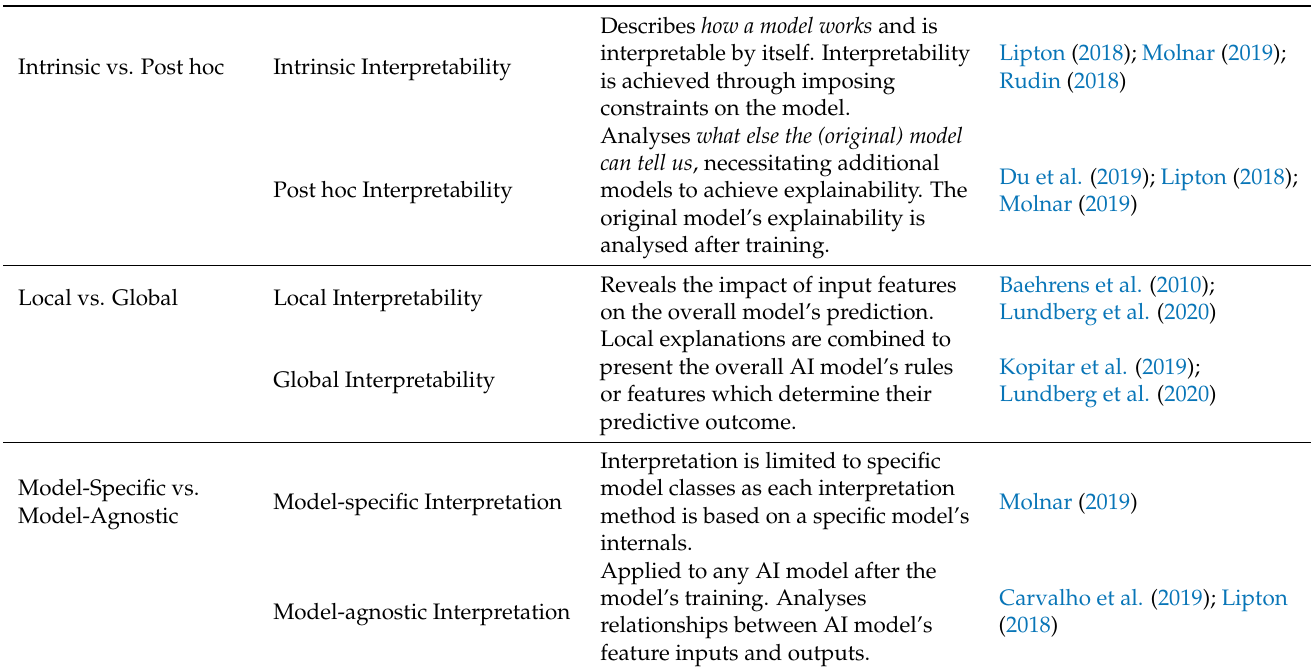
Table 1. XAI Variables used during the literature analysis to assess the explainability of AI systems applied within insurance industry practices. Reference Appendix A for additional discussion on XAI variables used during